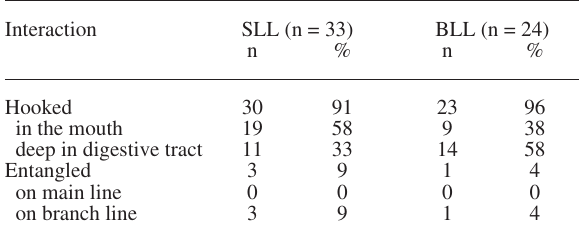
Table 3. – Capture mode of turtles in two types of longline (Sll and Bll) during the study in the zone of Zarzis.